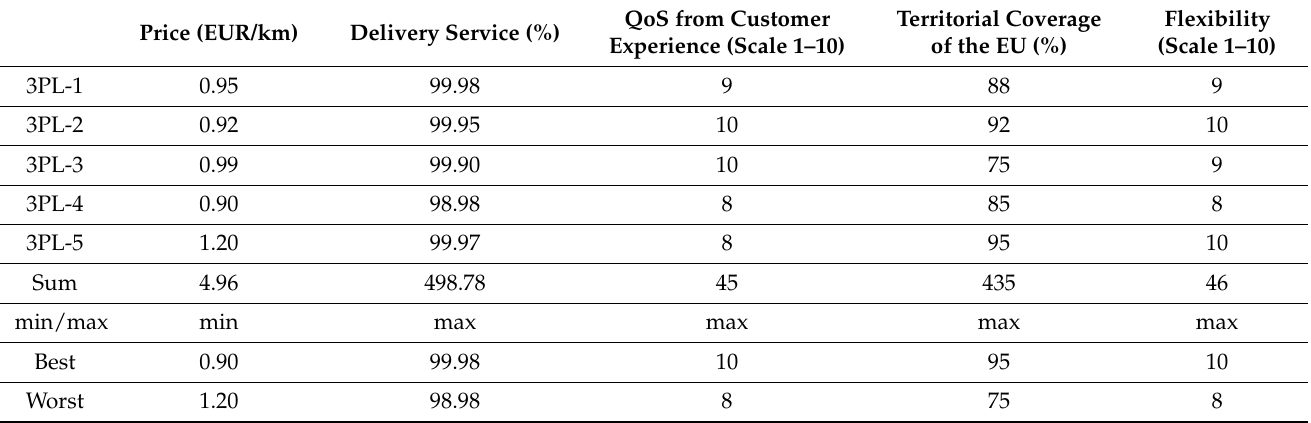
Table 6. Initial CRITIC decision-making matrix (Source: Authors).